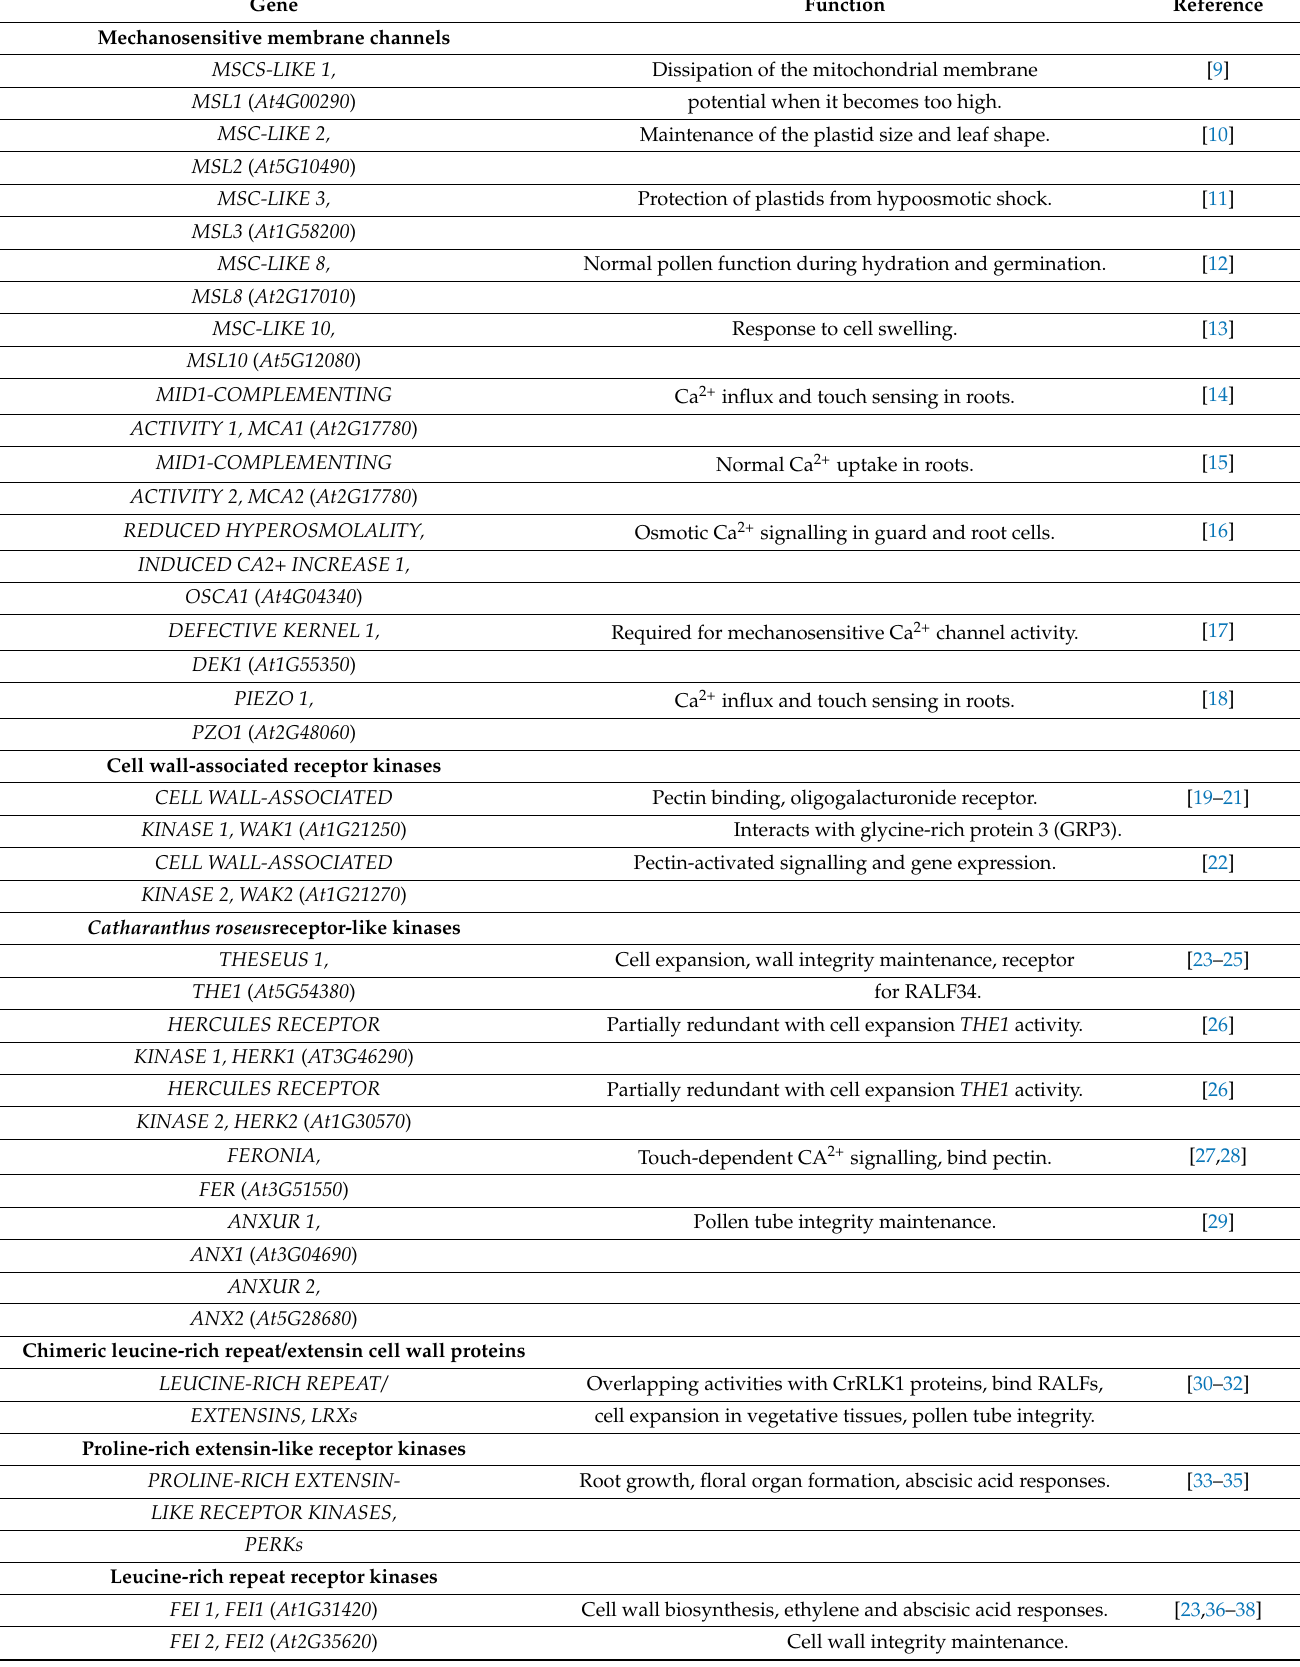
Table 1. Mechanosensitive channels and cell surface receptors involved in cell wall integrity responses. Gene